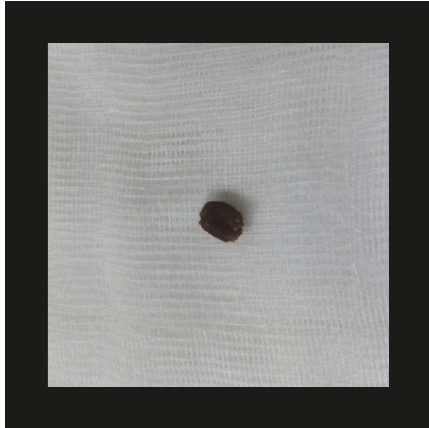
Figure 6: Extracted urethral stone (case 1).